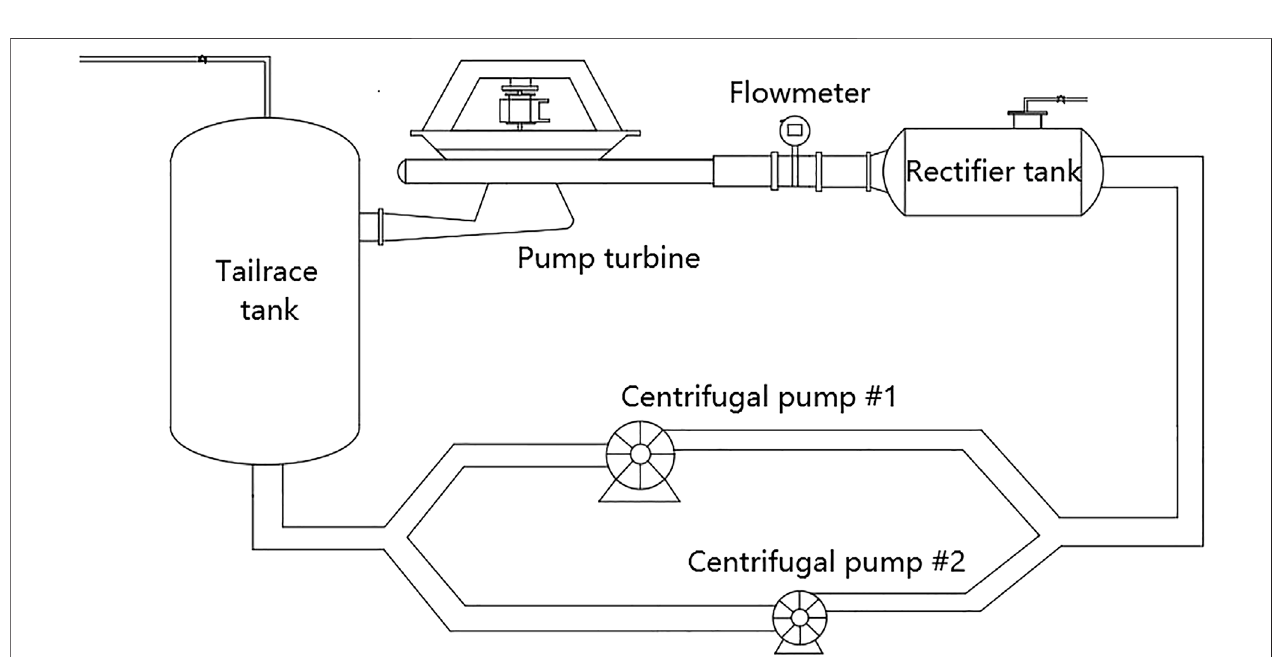
FIGURE 3 | Pump turbine test